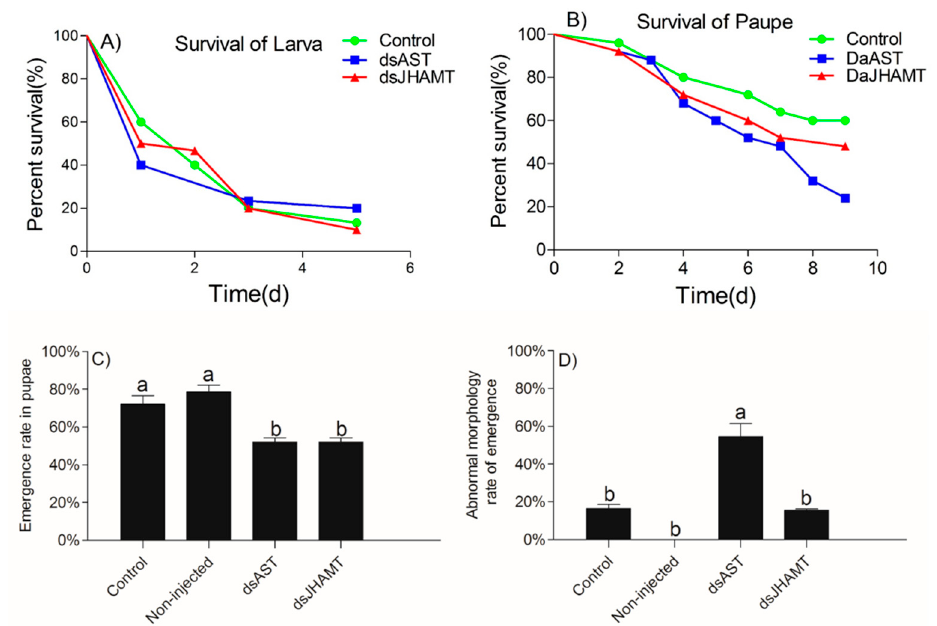
Figure 8. Survival emergence and abnormal morphology rate in D. armandi larvae and pupae after RNAi. Effect of bacterially expressed dsAST/JHAMT on D. armandi larvae and pupae. ( A ) Survival rate in larvae, ( B ) survival rate in pupae, ( C ) emergence rate in pupae and ( D ) abnormal morphology rate in pupae. There were 25 samples in each biological repetition. The data were analyzed by a one-way ANOVA test. Different letters above the bars indicate a significant difference ( p < 0.05).